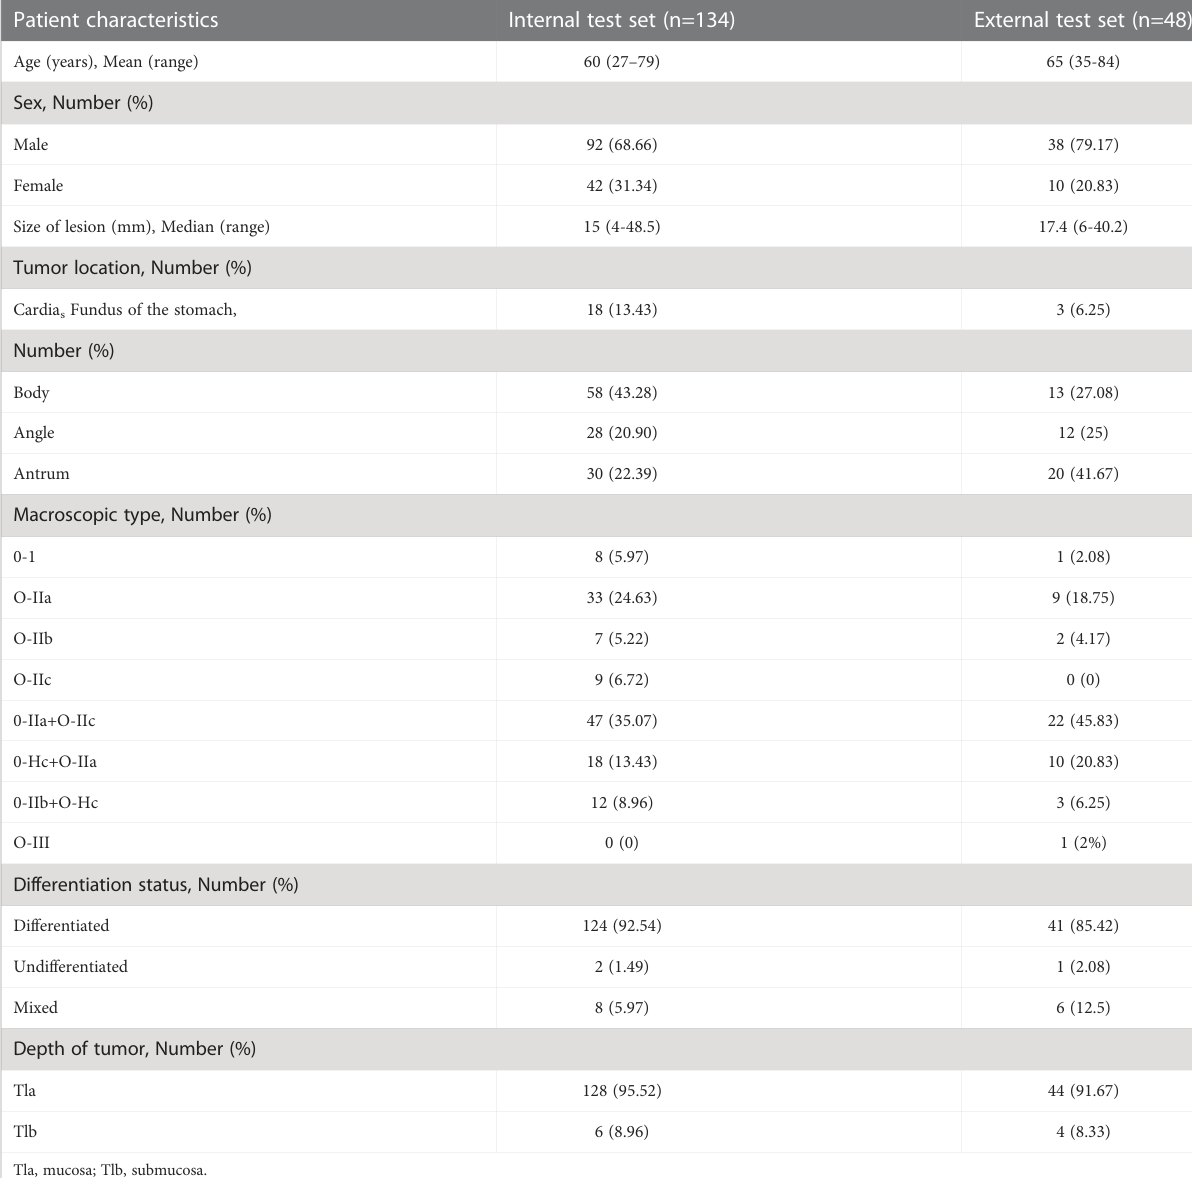
TABLE 1 Patient and lesion characteristics of EGC in Internal test set and External test